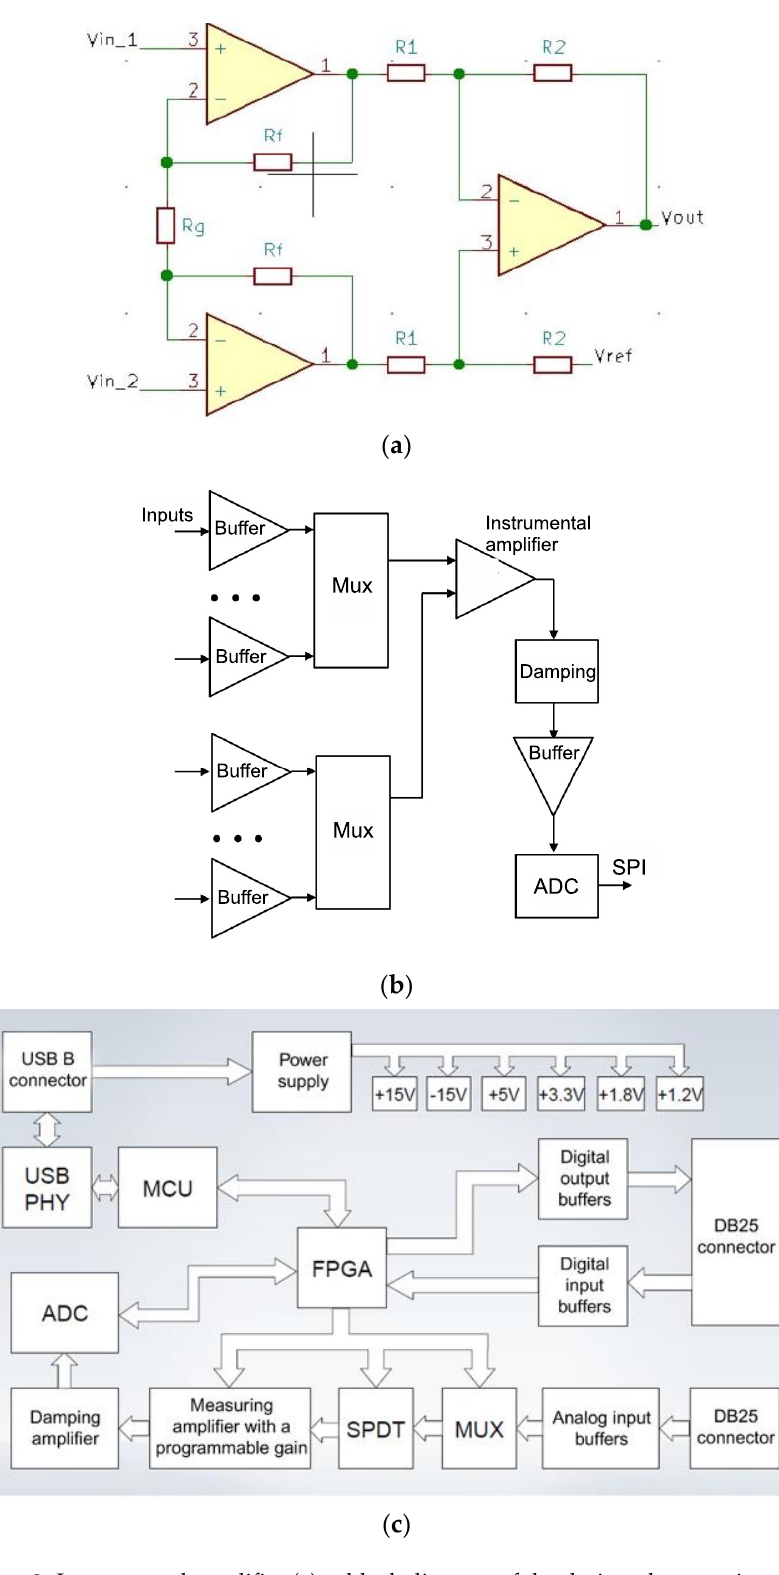
Figure 2. Instrumental amplifier ( a ), a block diagram of the designed measuring module together with the direction of the flow of signals from individual subsystems ( b ), and a block diagram of the device ( c ).